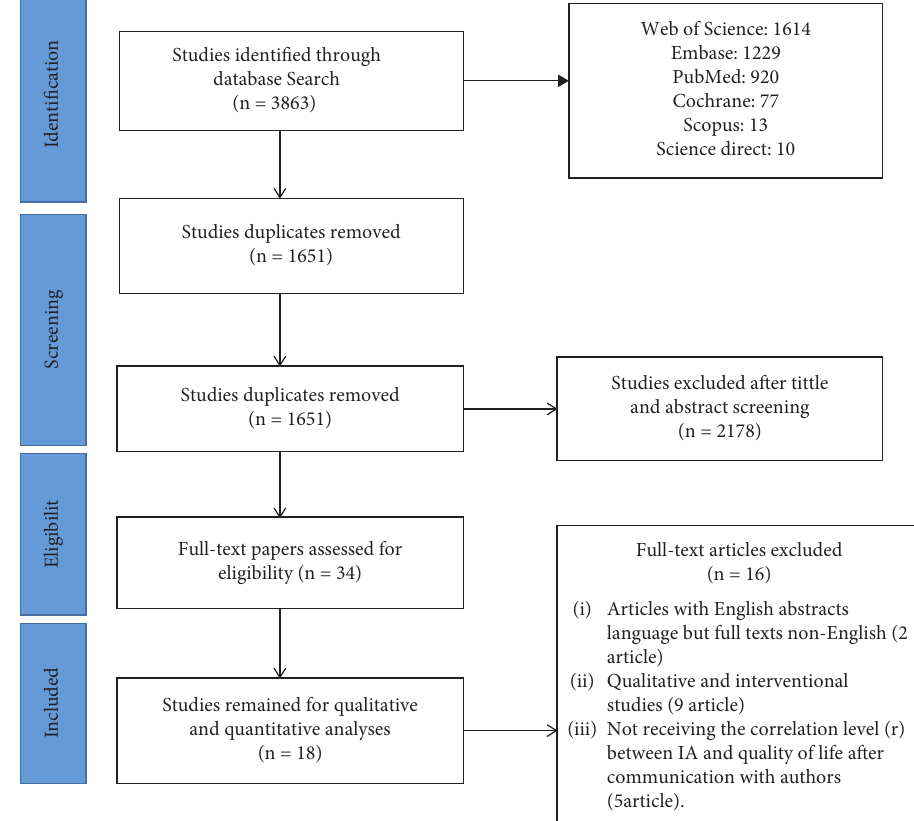
Figure 1: Flowchart of the included studies in systematic review.